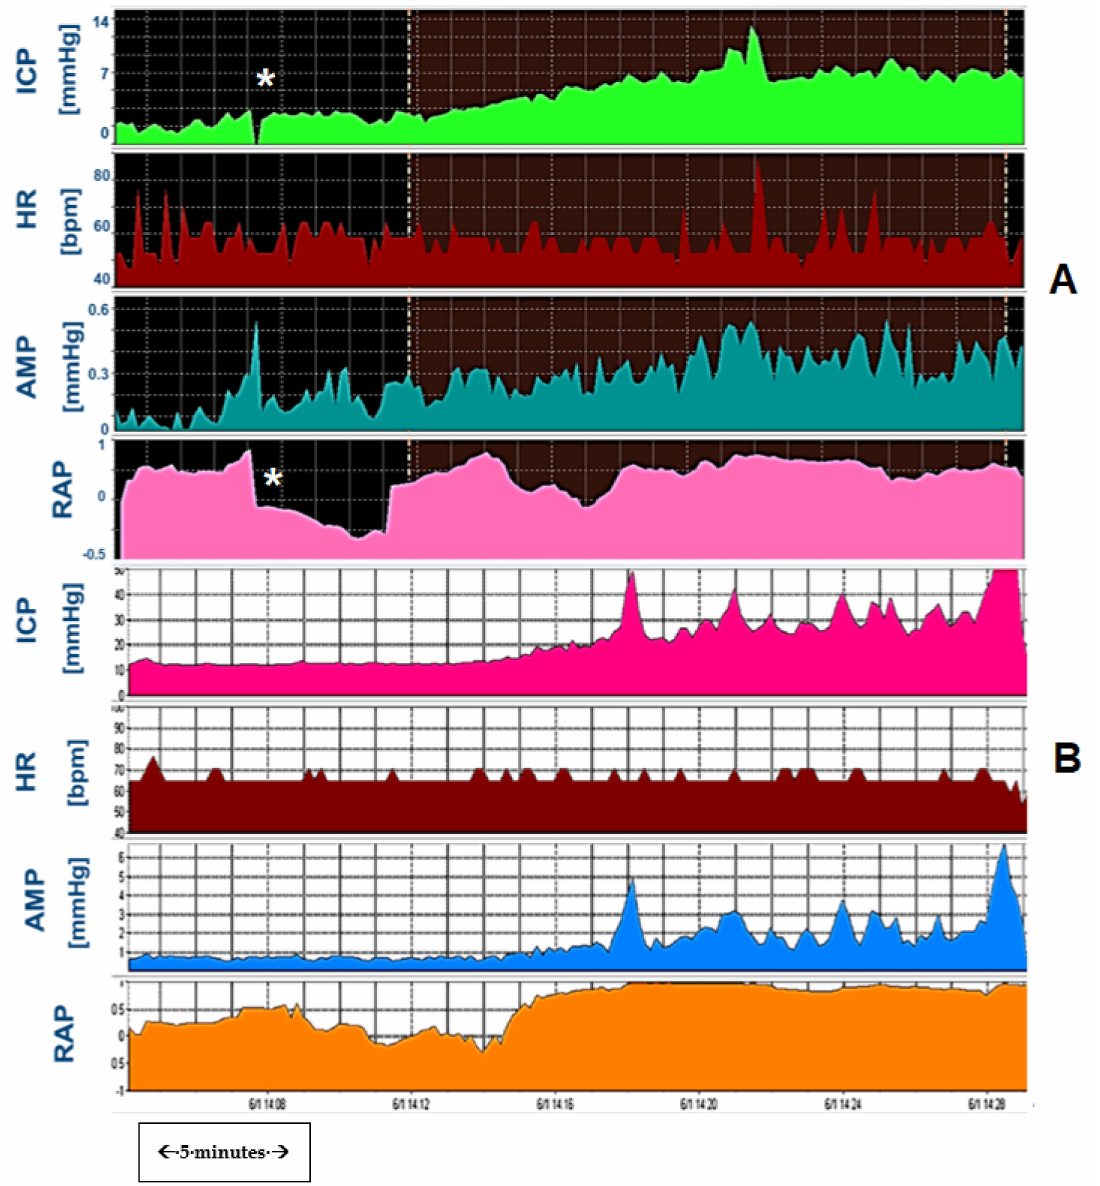
Figure 11. Shunt infusion study results. ( A ): Normal study: Normal ICP at baseline and plateau ICP below critical pressure and normal compensatory reserve (RAP around <0.6). Asterisk: movement artefact, causing artificial dips and spikes in the recorded parameters. ( B ): distal obstruction, During infusion, ICP exceeded the shunt critical pressure [inherent property of each manufactured shunt type, calculated by the formula Critical ICP = Rout*Infusion rate + Shunt operating pressure + Intra-abdominal pressure (5 mmHg)]. The rise in pressure was significantly above the critical pressure, rising to levels >40 mmHg, despite initial ICP within the normal range. Note that pulse amplitude of ICP is well detected, indicating ventricular drain to be